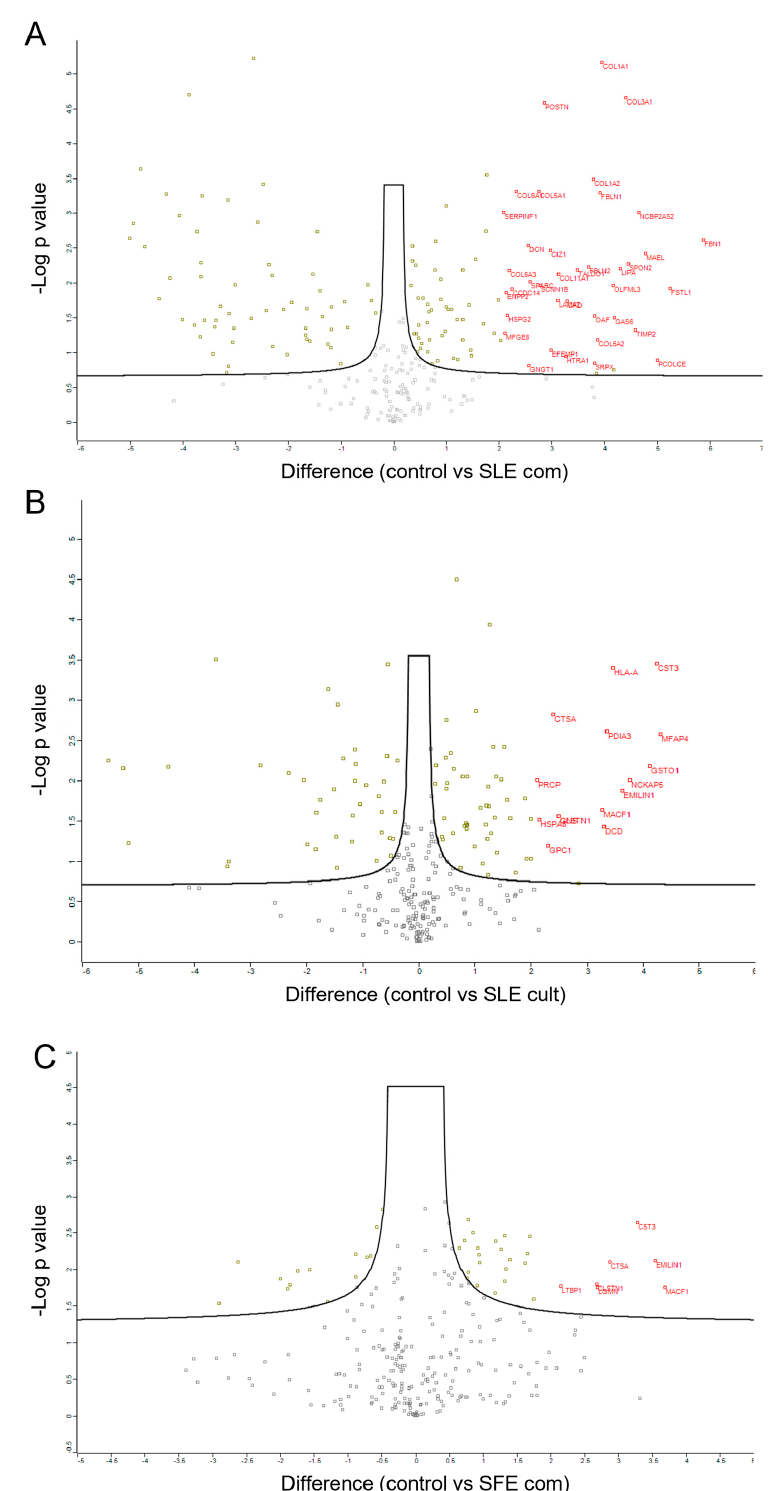
Figure 4. Volcano plots of differentially regulated proteins detected by LC-MS/MS Mass Spectrometry. C. vulgaris extracts mediate changes in the paracrine function of licensed MSCs, detected as differentially regulated proteins in their secretome. The y -axis is the -Log of the p -value while the x -axis is the fold difference relative to reference control, with 0 (no difference) being in the middle of the volcano plot. The black curve denotes the statistical significance limit of α = 0.05 ( p -value has to be less than 0.05 for significance). Dots that fall below the black curve do not pass the significance test (light gray dots).